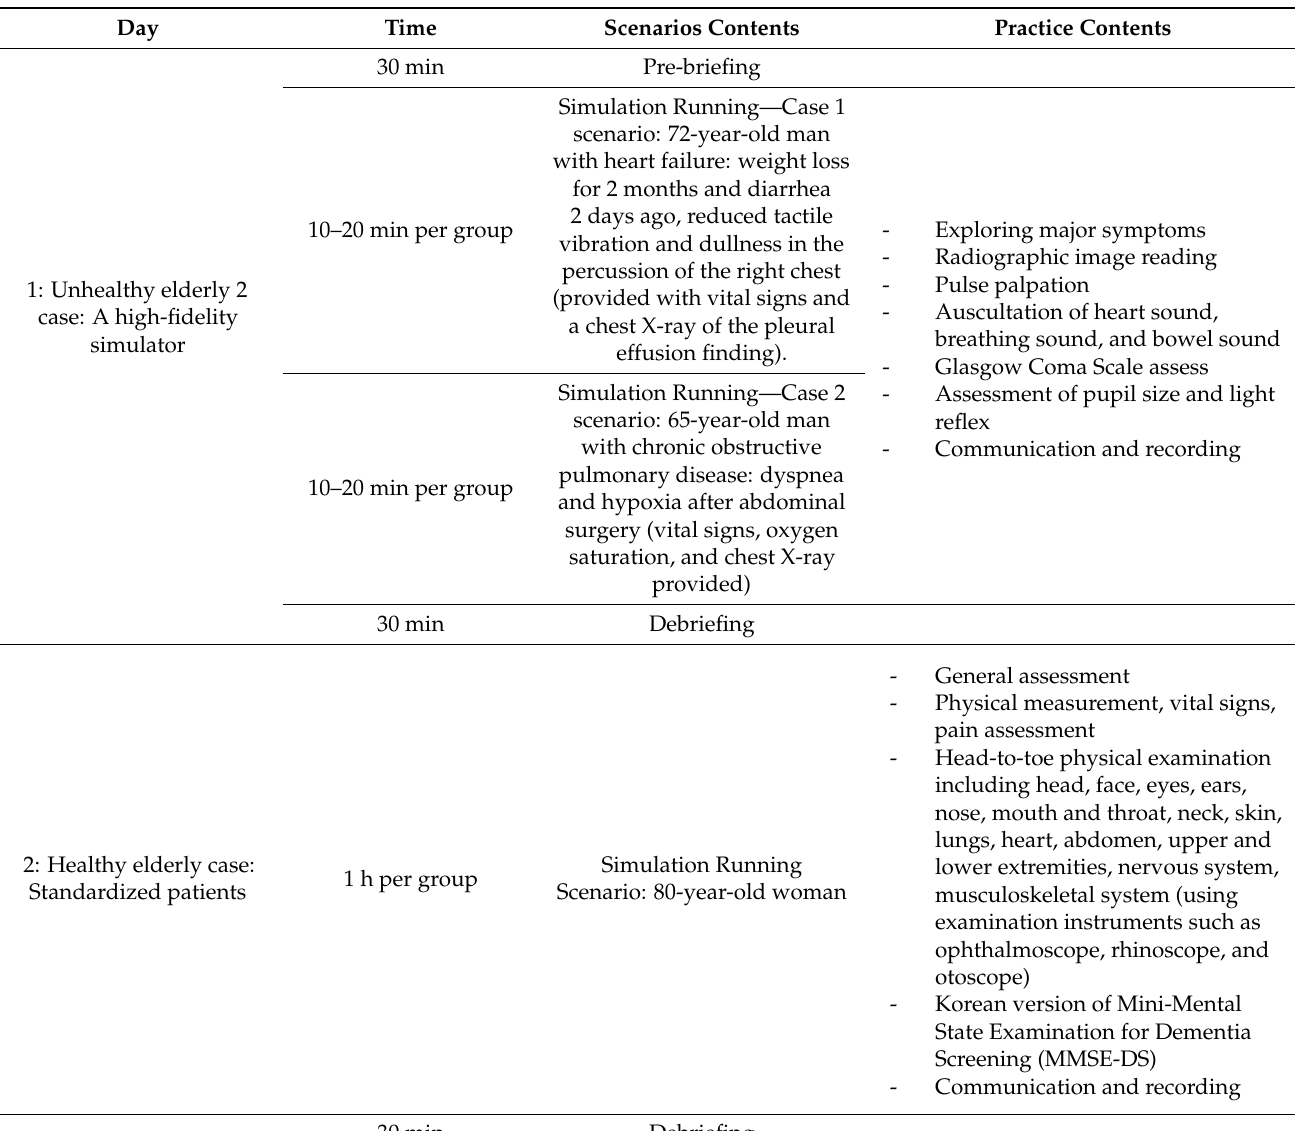
Table 2. Overview of the Developed Simulation